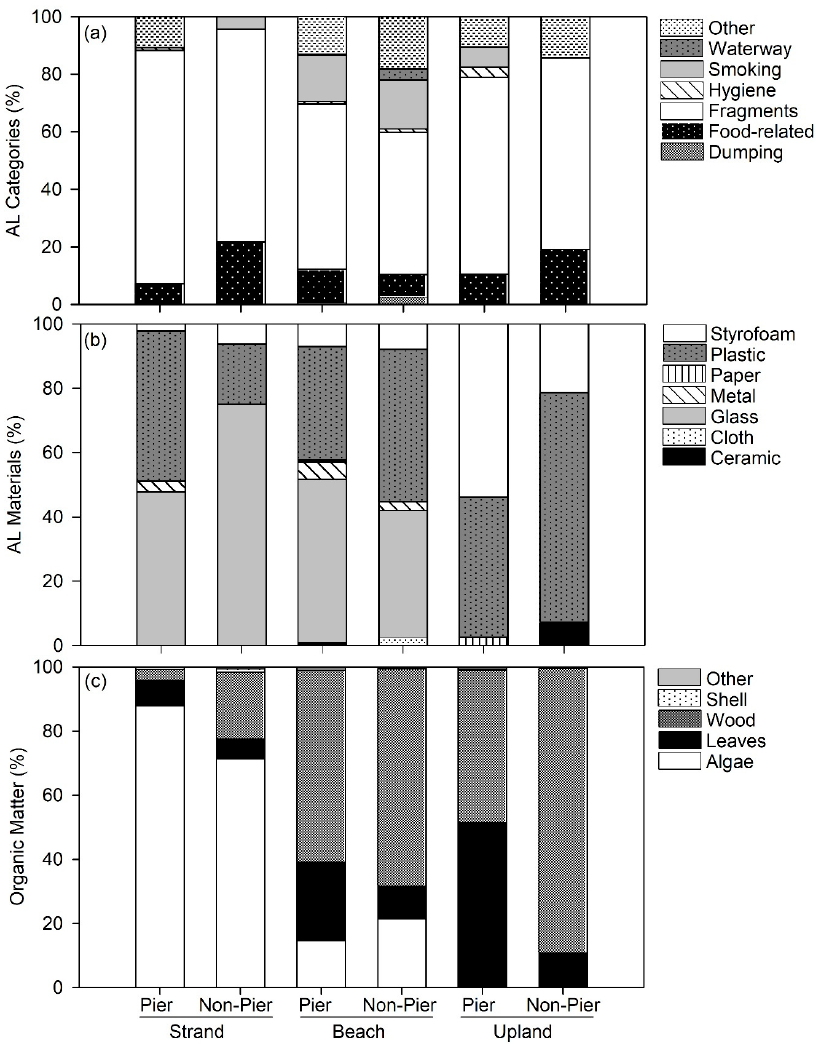
Figure 4. ( a ) Relative abundance (%) of anthropogenic litter (AL) according to category, and ( b ) material type by habitat type and pier proximity. ( c ) Relative abundance (%) of coarse particulate organic matter (CPOM) by habitat type and pier proximity.